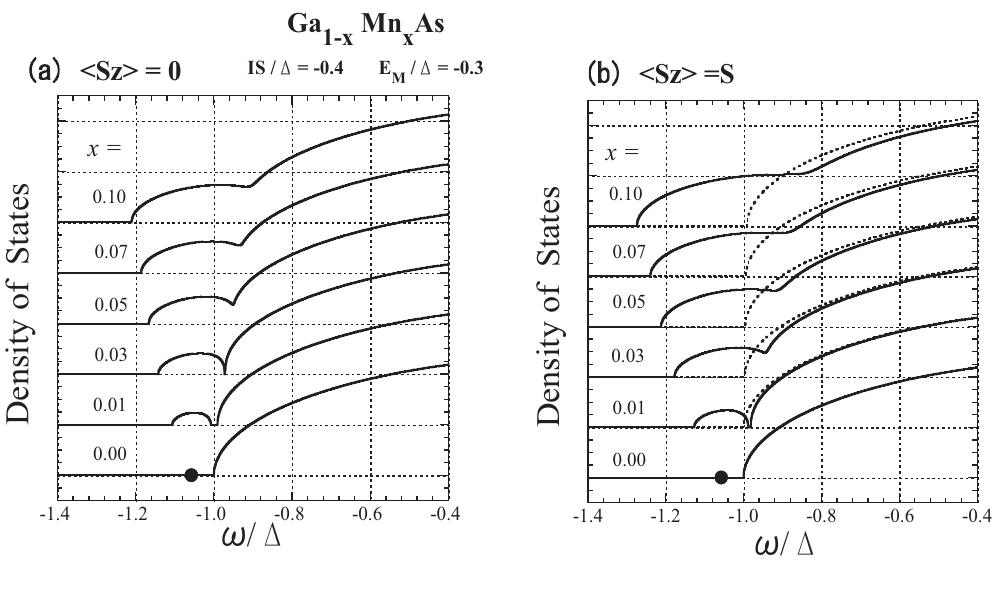
Figure 13. The lower-energy part of the DOS of Ga Mn As for various values 1 − x x ⟩ = 0 and (b) ⟨ S ⟩ = 0 . The solid lines represent the down-spin of x : (a) ⟨ S z z carrier and the dotted lines represent the up-spin carrier. The impurity level E = − 1 : 057∆ is indicated by a dot on the line x = 0 . From Takahashi and a Kubo